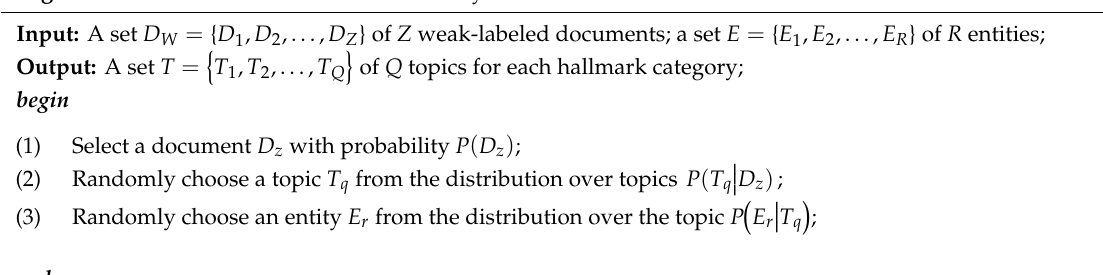
Algorithm 5 Probabilistic latent semantic analysis